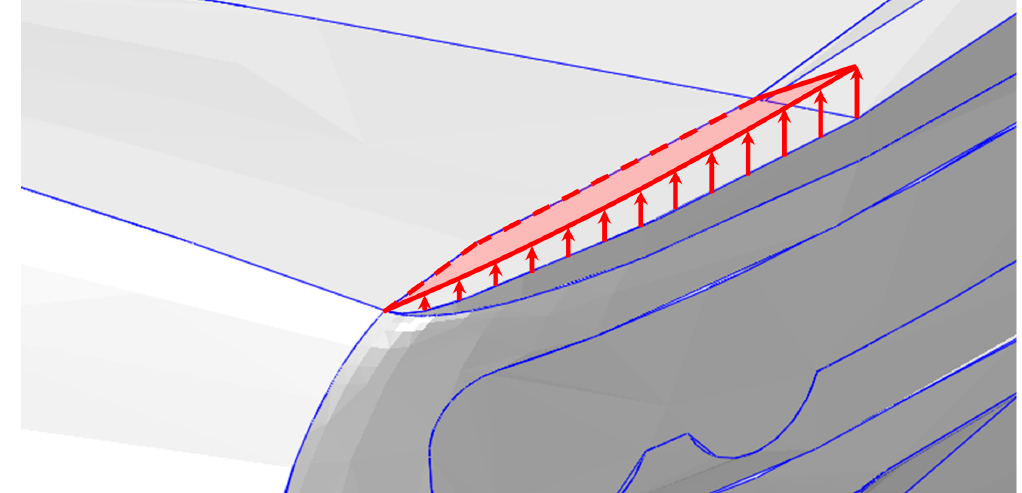
Figure 4. Rear panel actuation.